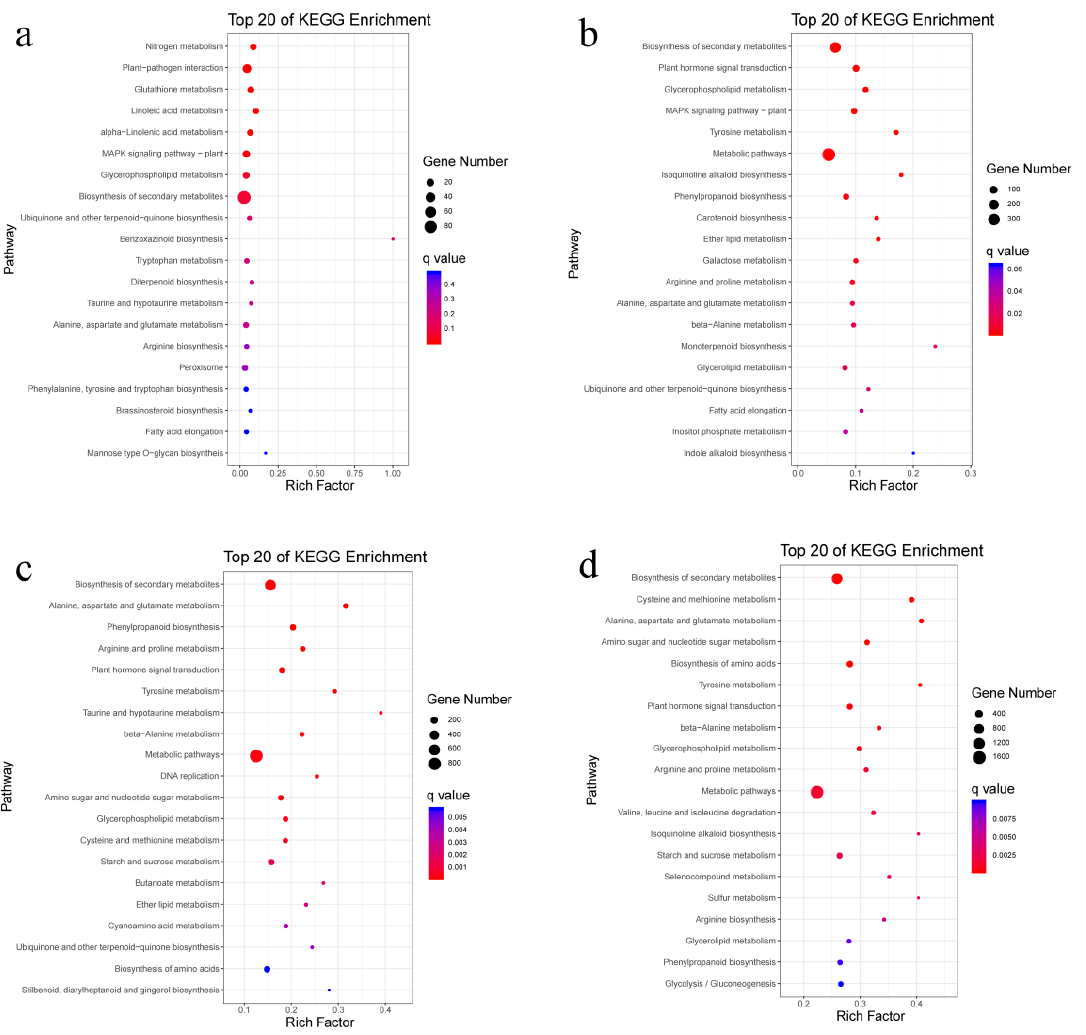
Figure 3. KEGG enrichment analysis of DEGs at each time point in the roots. ( a – d ) represent gene enrichments at 24 h, 48 h, 96 h and 144 h, respectively. DEGs, differentially expressed genes; KEGG, Kyoto Encyclopedia of Genes and Genomes. 3.3. Analysis of ABA Hormone Transduction and Zeatin Signal Transduction Related Genes The enrichment analysis of the pearl millet root signaling pathway that revealed sig- nificant enrichment of genes involved in the “plant hormone signaling pathway” and “ABA hormone transduction” were analyzed in more detail (Figure 4). In this experiment, we found that two ABA receptor PYL genes ( i2_LQ_LWC_c3719/f1p0/2678 and i1_HQ_LWC_c37349/f3p10/1291 ) were differentially expressed in the roots under drought stress. i2_LQ_LWC_c3719/f1p0/2678 was downregulated at 48 h, 96 h and 144 h, while i1_HQ_LWC_c37349/f3p10/1291 was upregulated at 144 h. A total of 27 PP2C genes were differentially expressed in the roots. Most were upregulated from 48 h to 144 h, and 10 PP2C genes saw more than a five-fold upregulation. There were 15 SnRK2 genes that were differentially expressed at 96 h and 144 h in the root, and 14 of the 15 genes were upregu- lated.